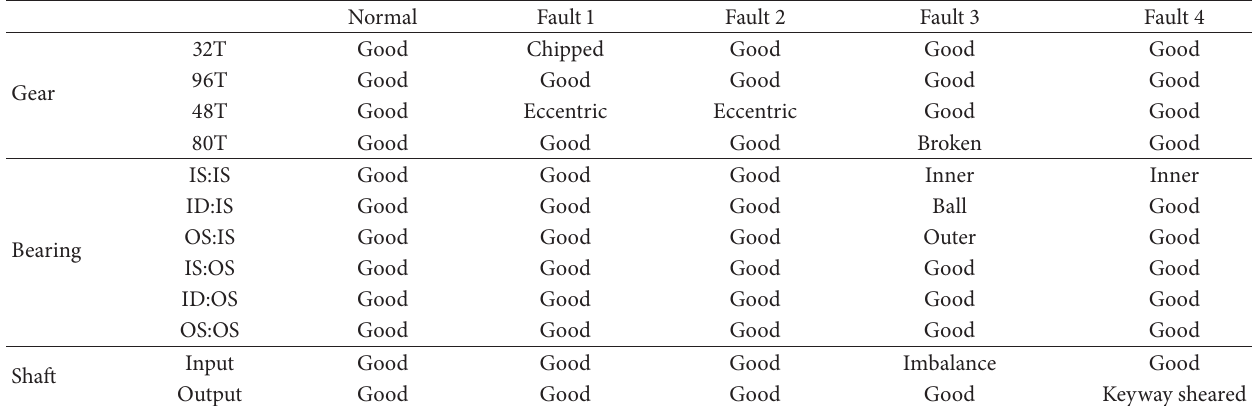
Table 1: Fault information of gearbox.